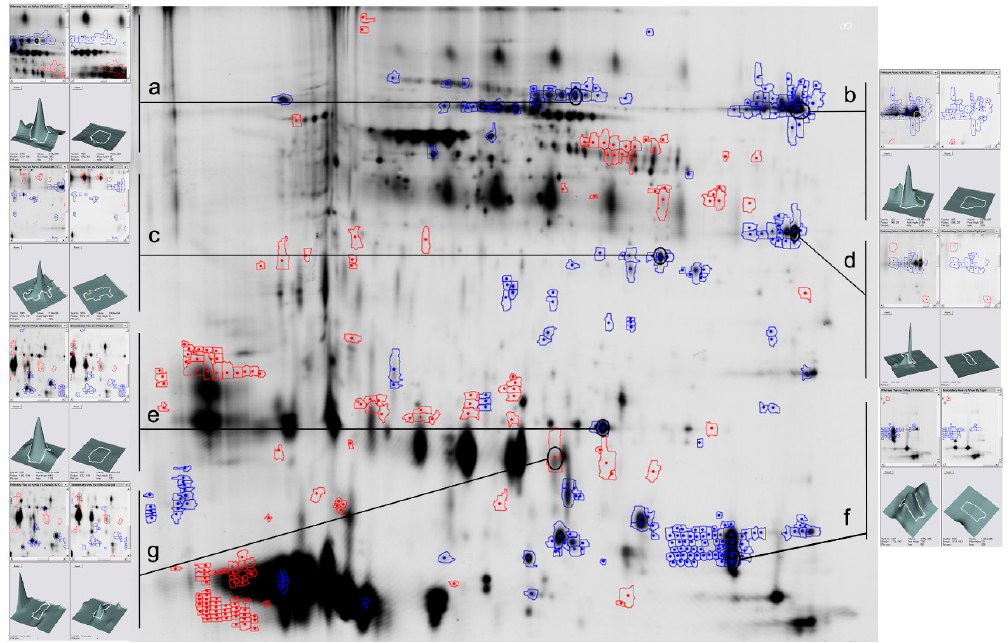
Figure 2. Representative image of difference gel electrophoresis (DIGE) analysis of seminal plasma proteins from intact and vasectomized rams. Angiotensin-converting enzyme ( a ), lactotransferrin ( b ), sorbitol dehydrogenase ( c ), phosphoglycerate kinase ( d ), epididymal secretory glutathione peroxidase ( e ), epididymal secretory protein E1 ( f ) and inactive ribonuclease-like protein 9 ( g ) spots are identified.